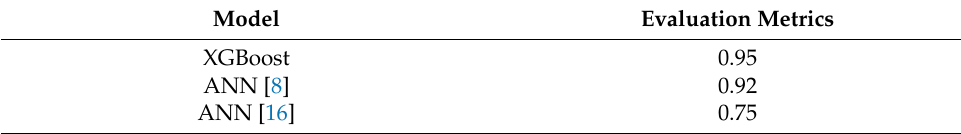
Table 12. Comparison of XGBoost model with models from related studies.